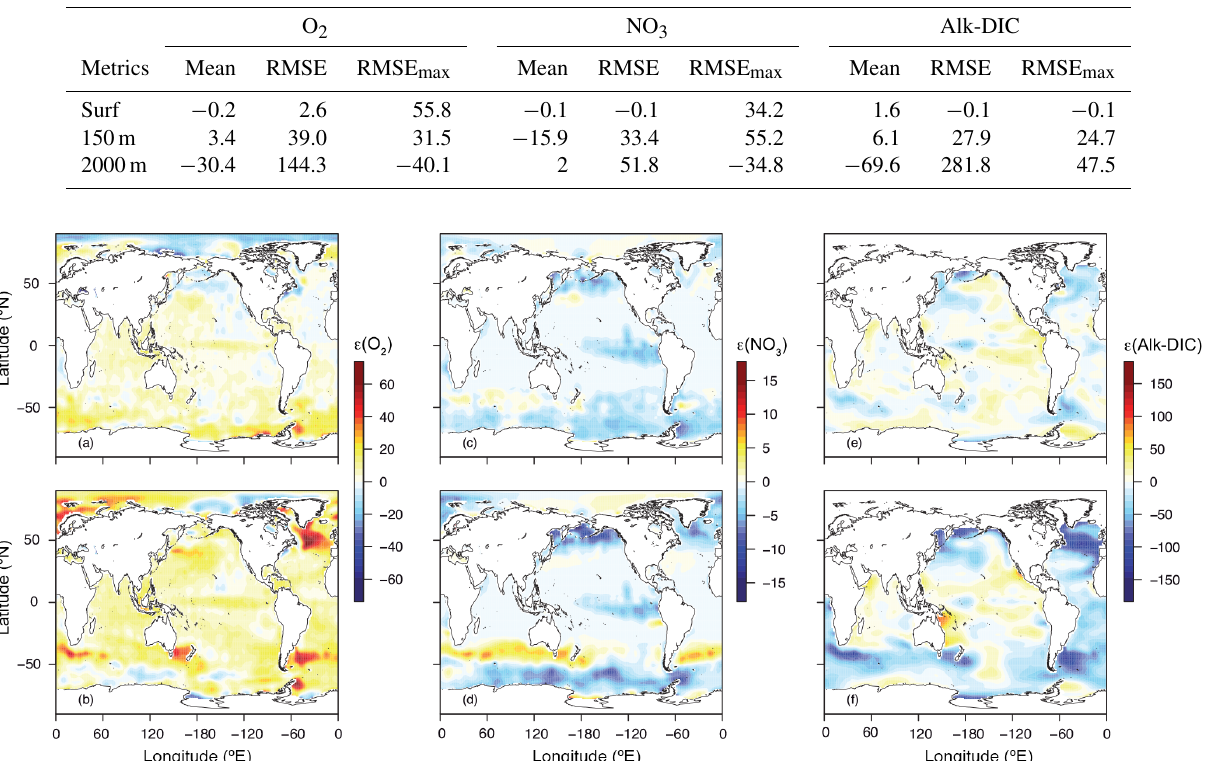
Figure 4. Snapshots of spatial biases, ε , in surface concentrations (µmolL − 1 ) in biogeochemical fields during the 500-year spin-up simulation of IPSL-CM5A-LR. ε in dissolved oxygen (O 2 ), nitrate (NO 3 ) and difference between alkalinity and dissolved inorganic carbon (Alk-DIC) is given for the first year ( a, c, e , respectively) and for the last year of spin-up simulation ( b, d, f ,